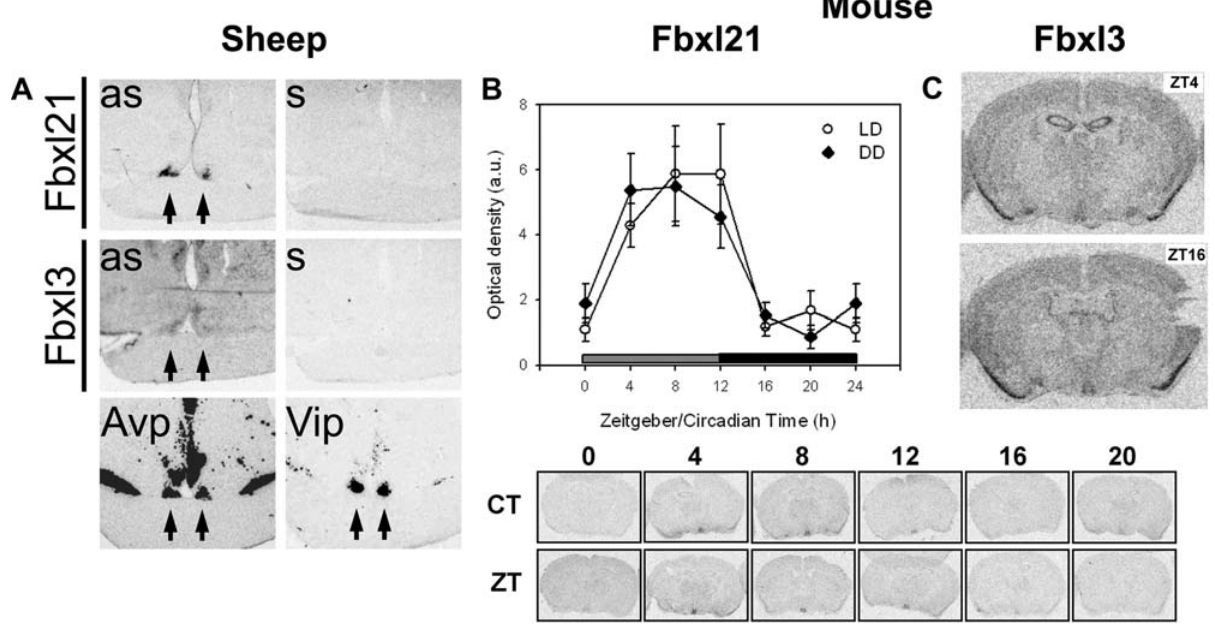
Figure 5. In-situ hybridisation for Fbxl3 and Fbxl21 within the SCN of the sheep and mouse. A . Representative images for expression of Fbxl21 (top), Fbxl3 and the neuropeptides, Avp and Vip (bottom) in the hypothalamus of sheep sampled at ZT4-6. Sense controls for Fbxl riboprobes are also shown (top and middle right panels). B . Fbxl21 undergoes circadian expression in the SCN of the mouse. Top: mRNA profiles in the SCN of mice sampled at 6 different time-points (n=5 per time-point) under either a 12/12 light-dark cycle (LD) or under constant darkness (DD). Data for ZT/ CT0 are double-plotted. Bottom: representative in-situ autoradiograms. Note the SCN-restricted pattern of expression. Two-way ANOVA: time-effect, P , 0.001, light condition 6 time interaction, p=0.39. C . Fbxl3 does not show circadian expression in the SCN of the mouse. Representative images for expression of Fbxl3 in the brain of mouse sampled at ZT4 and ZT16. Note the ubiquitous pattern of labelling including diffuse expression in the SCN.